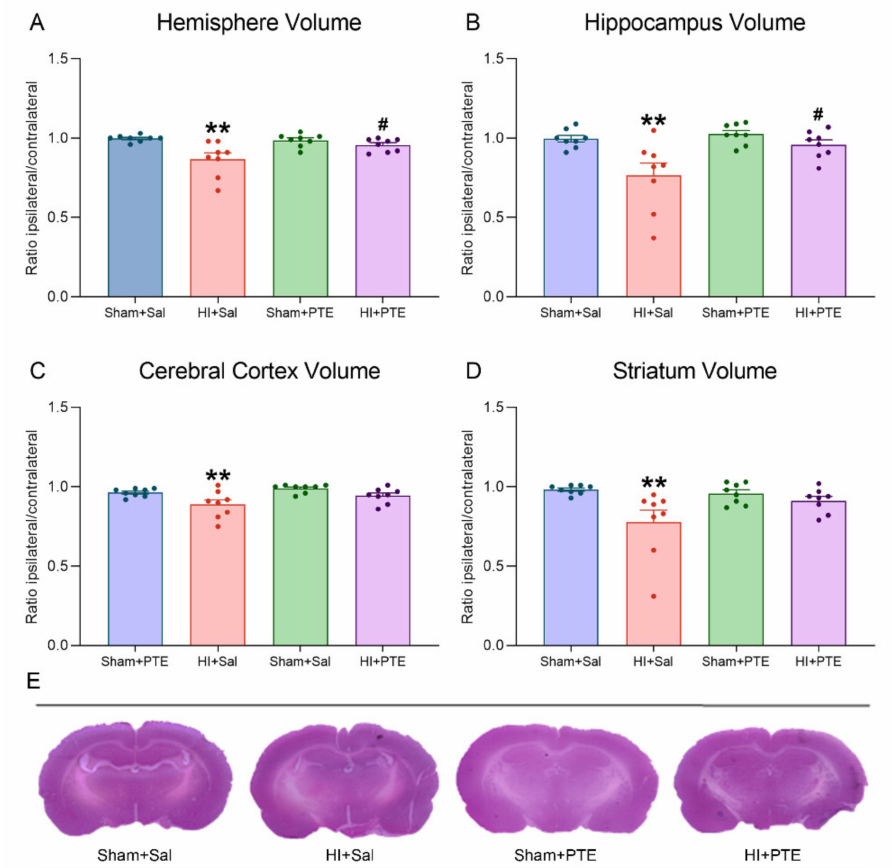
Figure 7. Ipsilateral/contralateral volume ratio of the hemisphere ( A ), the hippocampus ( B ), the cerebral cortex ( C ), and the striatum ( D ). Representative hematoxylin and eosin-stained coronal brain sections (Bregma − 3.3 mm) of adult rats ( E ). Data were calculated by dividing the volume of selected brain structure ipsilateral to the carotid occlusion (right side) by the contralateral volume. Data are expressed as mean ± SEM. * Injury effect (HI vs. control). # Treatment effect (Sal vs. PTE). n = 8 animals per group. Significance was accepted whenever p < 0.05 (* or #) or p < 0.01 (** or ##) (one-way